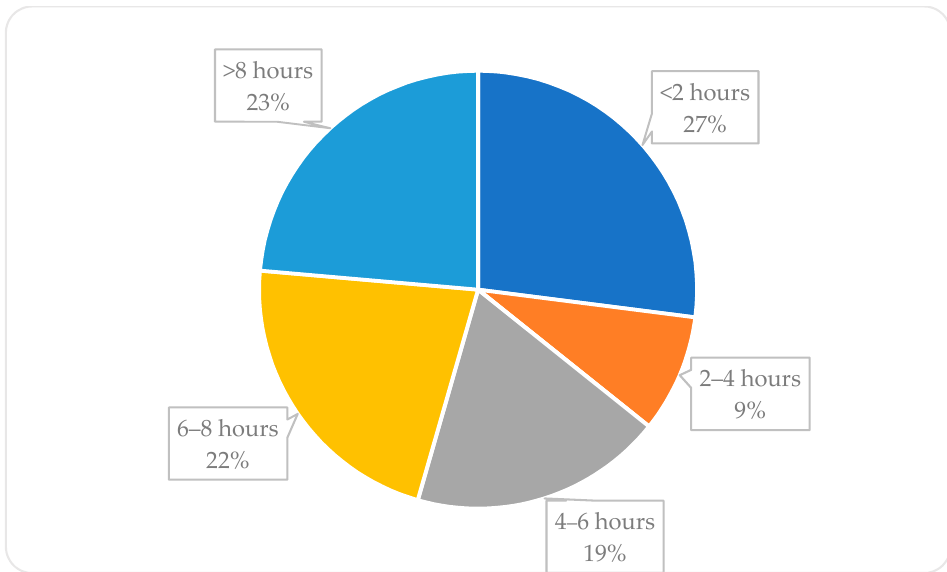
Figure 3. Time spent daily in front of blue-light-emitting devices.